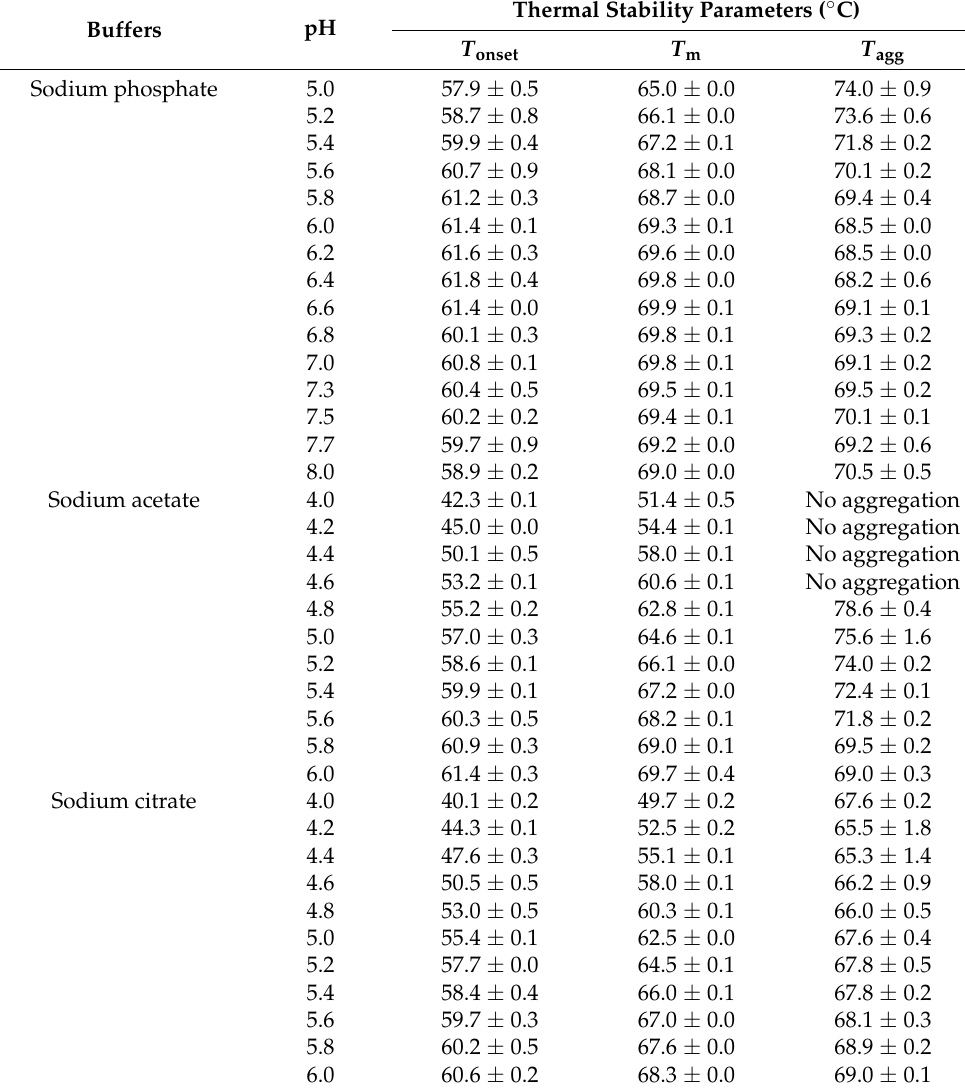
Table 1. Thermal stability of IgGs in three buffers with different pHs as measured by